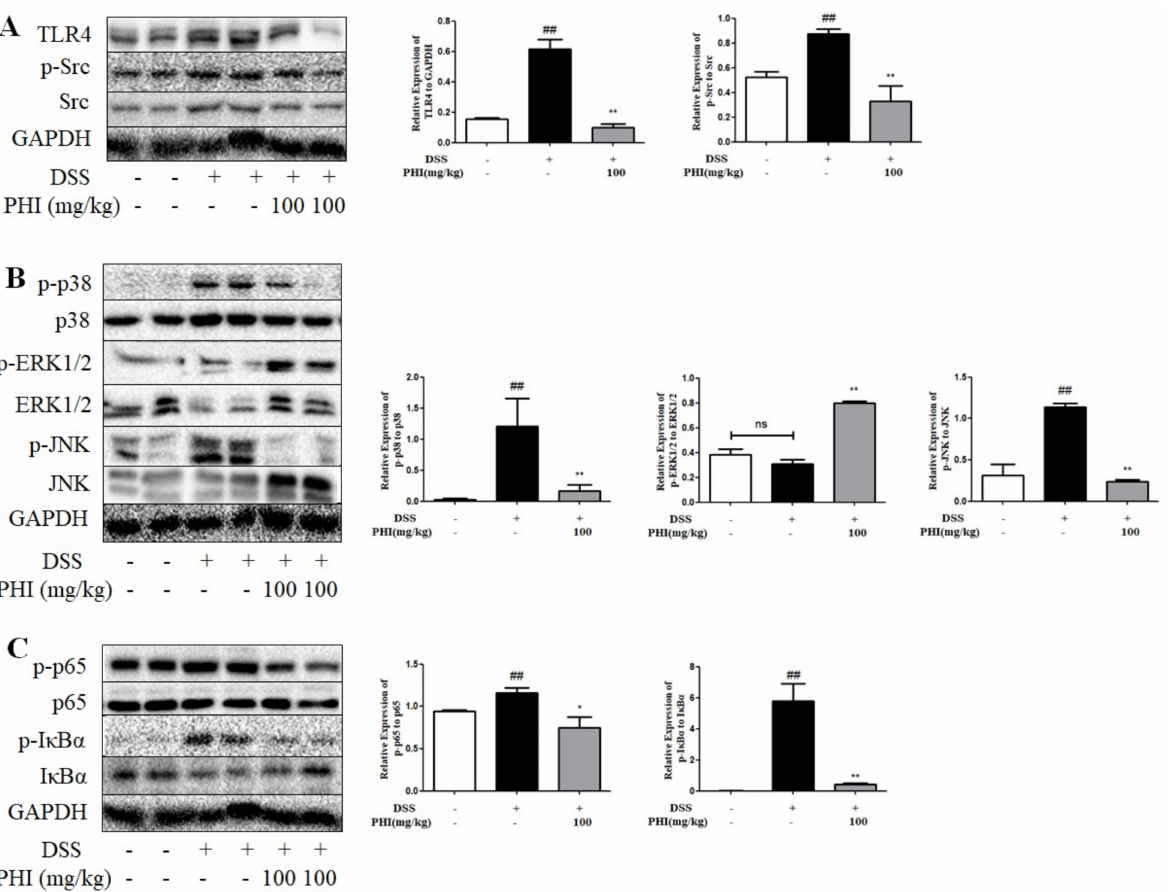
Figure 9. PHI treatment affected the expressions of TLR4, Src, and downstream NF- κ B and MAPK pathway proteins in DSS-induced colitis mice. ( A ) Protein levels of TLR4, Src, p-Src, ( B ) p38, p-p38, JNK, p-JNK, ERK1/2, p-ERK1/2, ( C ) p65, p-p65, I κ B α , and p-I κ B α in DSS-induced colitis mice were detected by Western blotting. ## p < 0.01 vs. control group. * p < 0.05and ** p < 0.01 vs. DSS group. “ns” represented not significant. ( n = 4 mice per